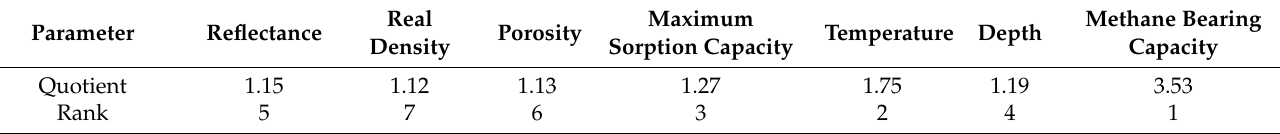
Table 4. Analysis of the neural network sensitivity for prediction of the maximum methane seam